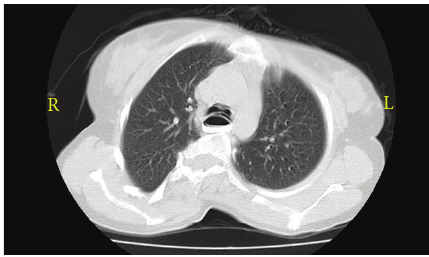
Figure 3: Widened